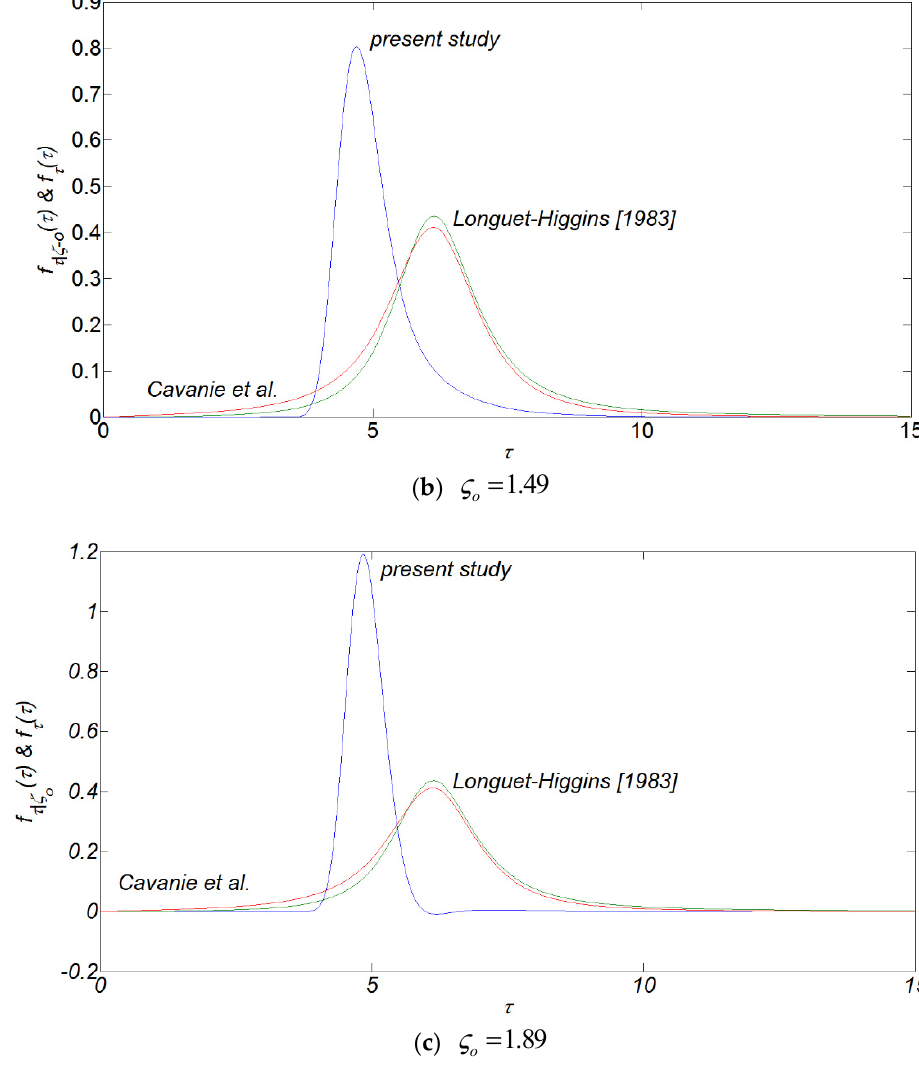
Figure 12. Comparison of f τ | ς